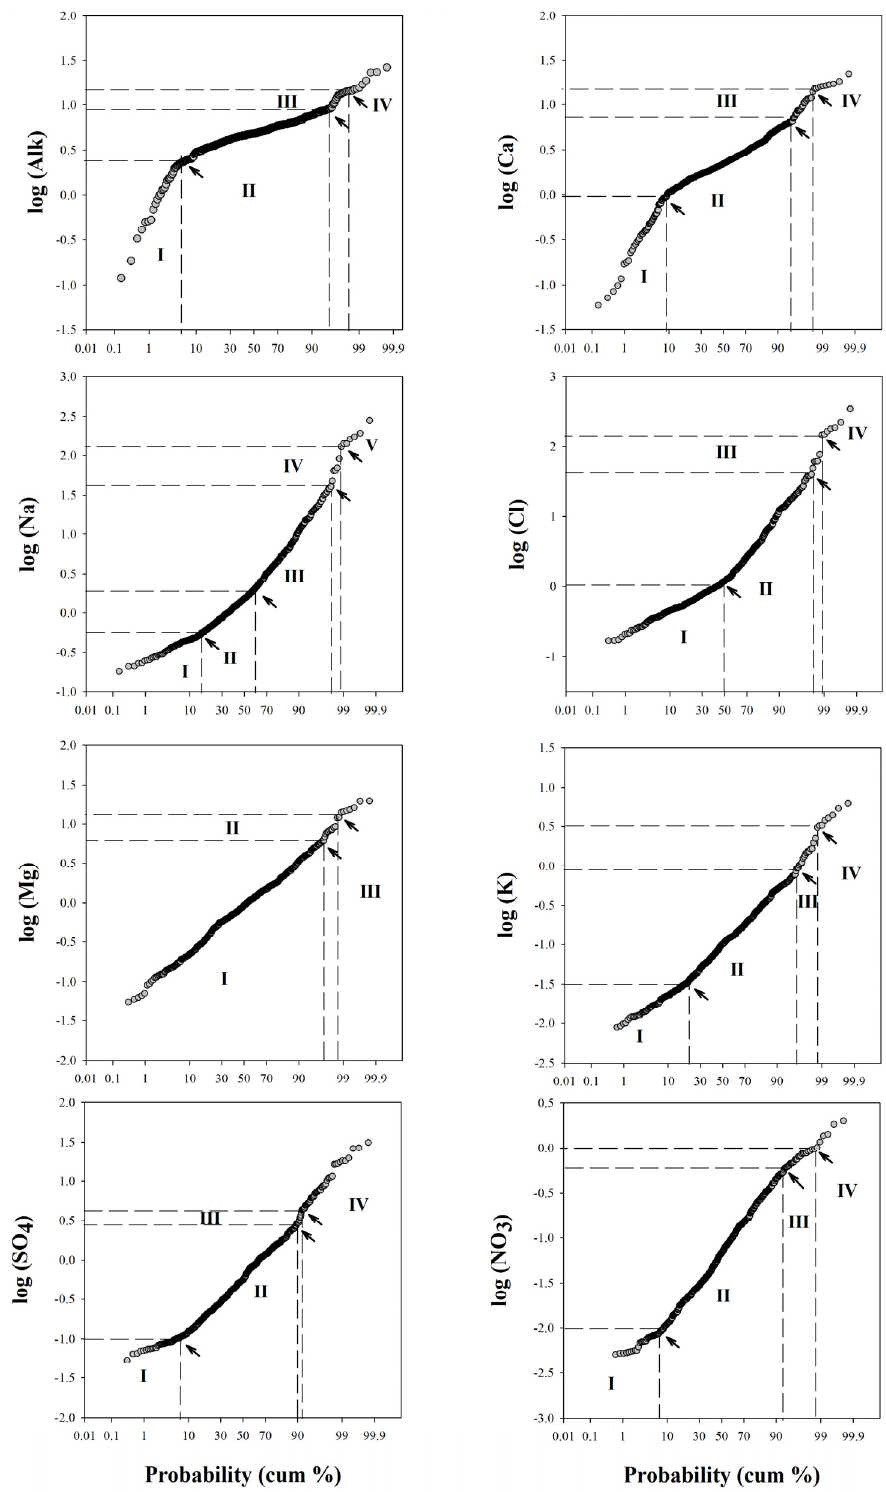
Figure 1. Normal probability plots (PPs) for every major element.